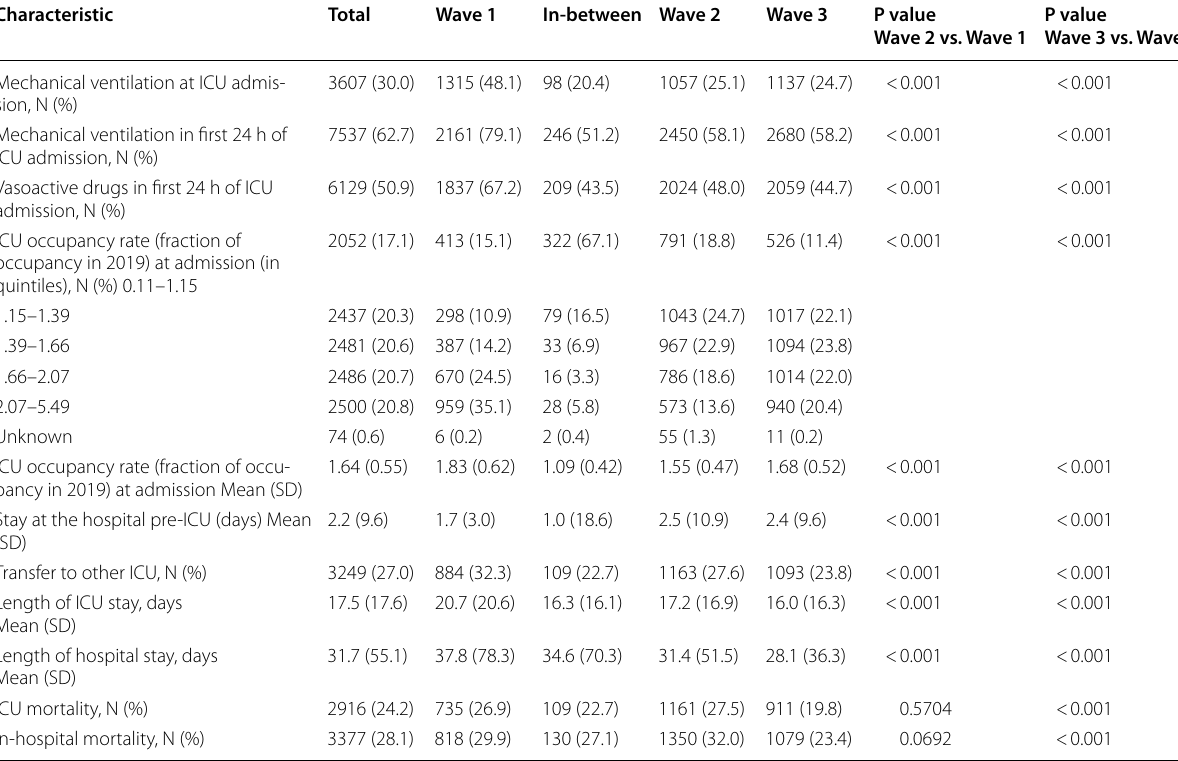
Table 2 Treatment characteristics and crude